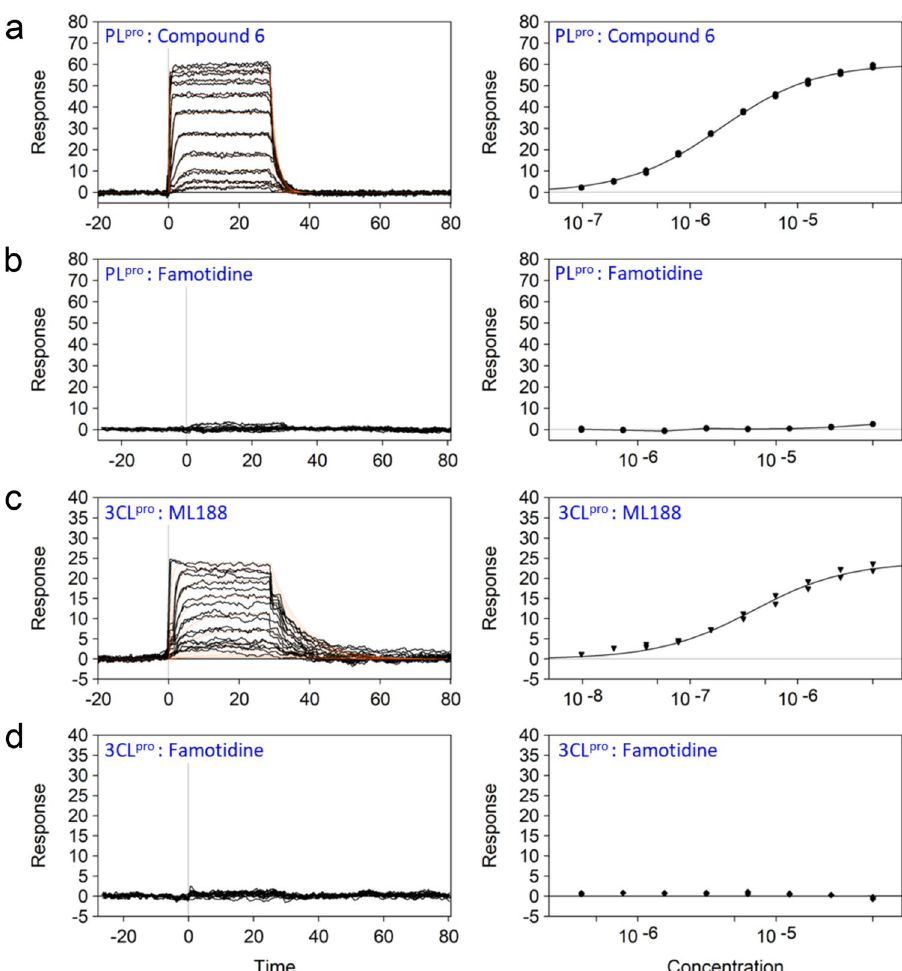
Figure 2. Binding of famotidine to PL pro and 3CL pro analyzed by SPR. Soluble biotinylated PL pro ( a , b ) and 3CL pro ( c , d ) were immobilized on a neutravidin-coated sensor chip and a range of compound concentrations were injected with solvent (DMSO) corrections. Both, ( a ) compound 6 , the known PL pro inhibitor and ( c ) ML188 , the 3CL pro inhibitor displayed dose-dependent binding to PL pro and 3CL pro , respectively. Whereas, ( b , d ) no binding of famotidine was detected to either protein. The dissociation constant ( K d ) values for the control compounds are shown in Table S1 (Supplementry